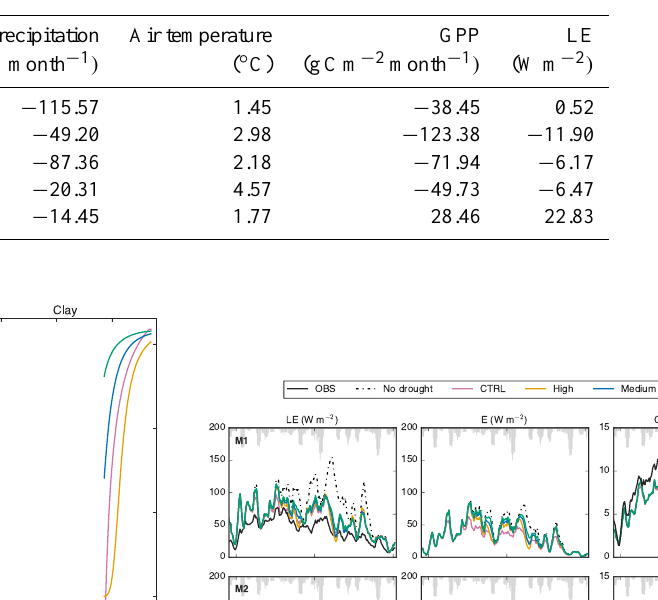
Table 3. Mean change in climate and fluxes between 2002 and 2003 covering the period between June and September.